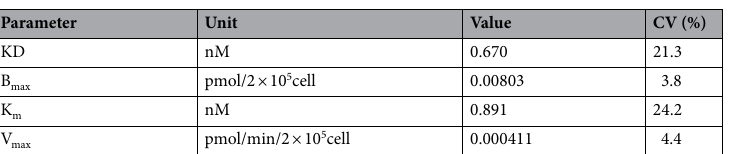
Table 3. PK parameters for the FcγRIIB-mediated binding and uptake in monkey NPC. The concentration- dependent binding and uptake profiles in monkey NPC were analyzed by the receptor-ligand binding equation and Michaelis–Menten equation,